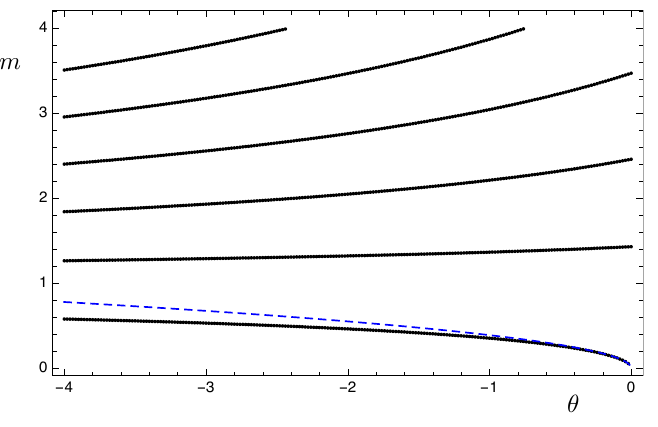
Figure 8 . Mass spectrum of spin-0 states normalized to the mass of the lightest spin-2 state for the hyperscaling violating toy model with d = 3, (cid:26) I = 0, (cid:26) U = 50. The dashed blue line is the perturbative result to leading order in (cid:18) given in eq.